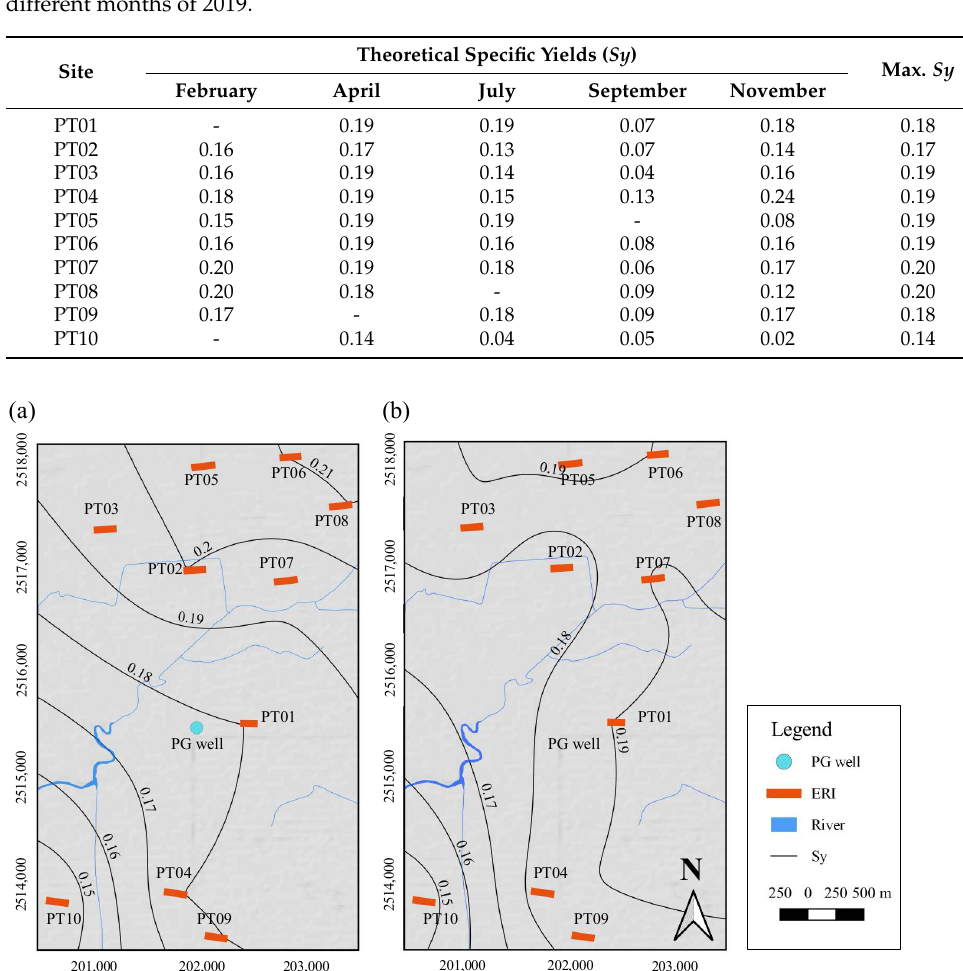
Figure 14. Spatial distribution of theoretical specific yield for April using ( a ) Van Genuchten, and ( b ) Brooks–Corey.